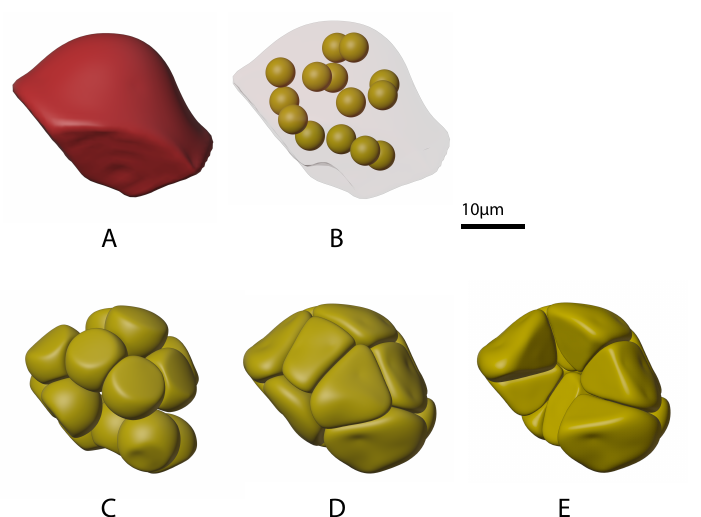
Figure 5. Progression of mini-gland acinus cell “growth” stages for one of the acini. ( Panel A ) shows one of the acinus outer boundaries in red colour. ( Panel B ) shows the arrangement of fourteen individual acinus cell “seeds” in yellow. ( Panel C ) shows partially grown acinus cells and ( Panel D ) shows the fully grown cells. ( Panel E ) shows the acinus with several of the cells removed. Note that the acinar cells are packed tightly together and conform to the associated acinus outer boundary.